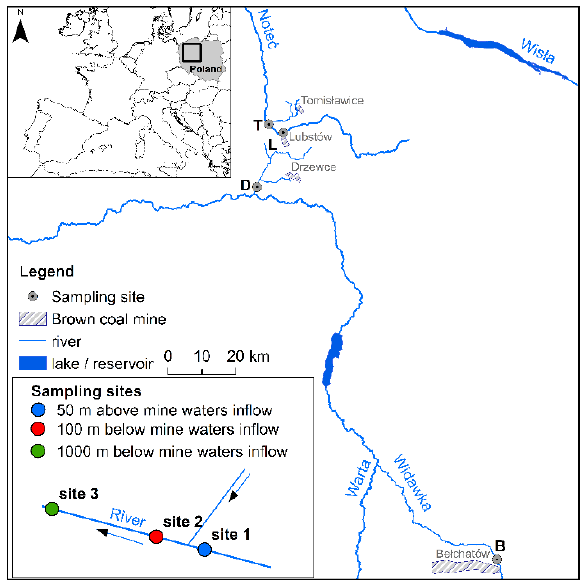
Figure 2. Study site